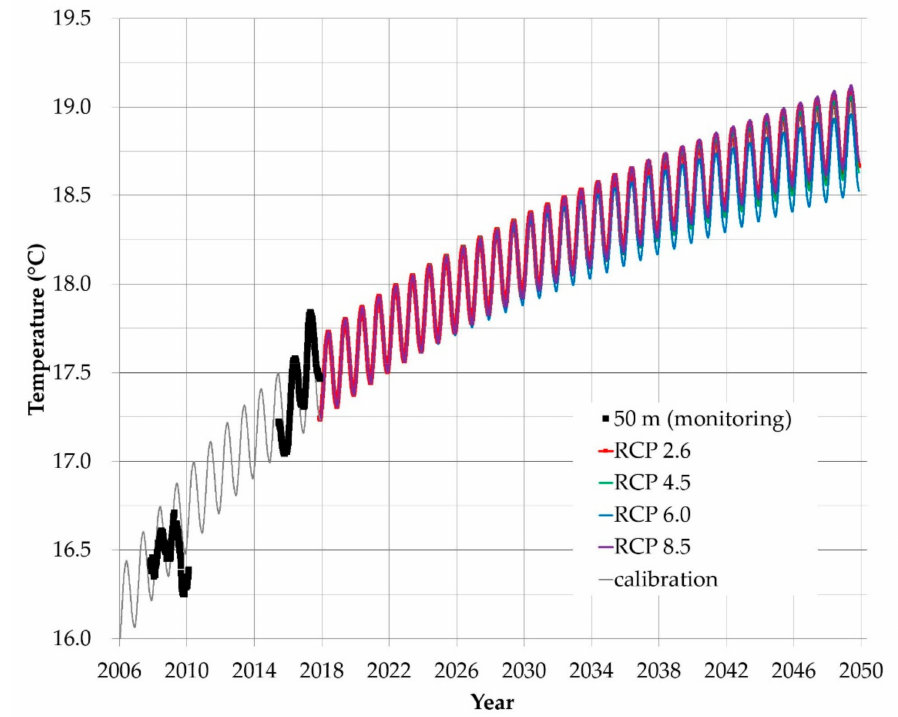
Figure 11. Temperature changes at the depth of 50 m in the groundwater monitoring well due to the operation of the GHP system under possible GSTs obtained from RCP 2.6, RCP 4.5, RCP 6.0, and RCP 8.5 as the time-dependent upper boundary